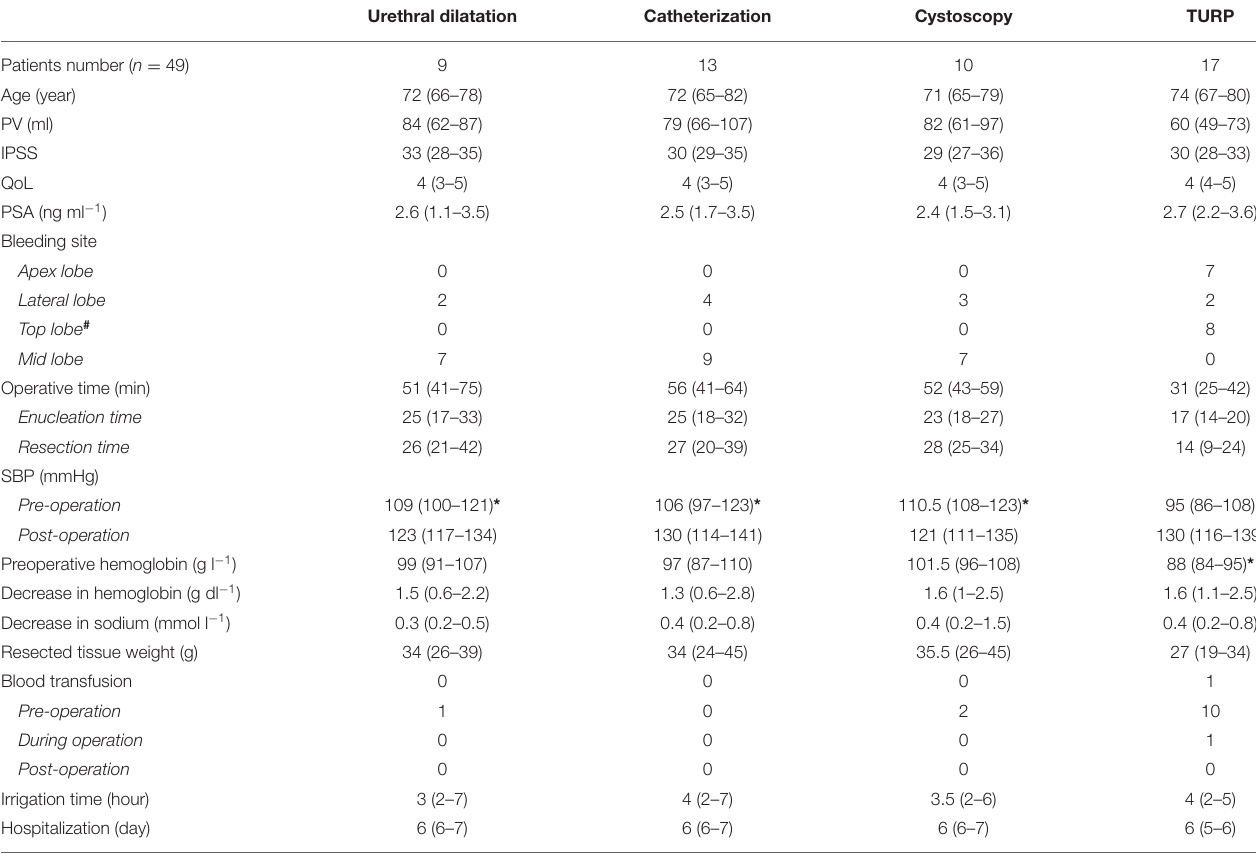
TABLE 1 | Perioperative characteristics of the patients with BMH (median, minima to maxima). Urethral